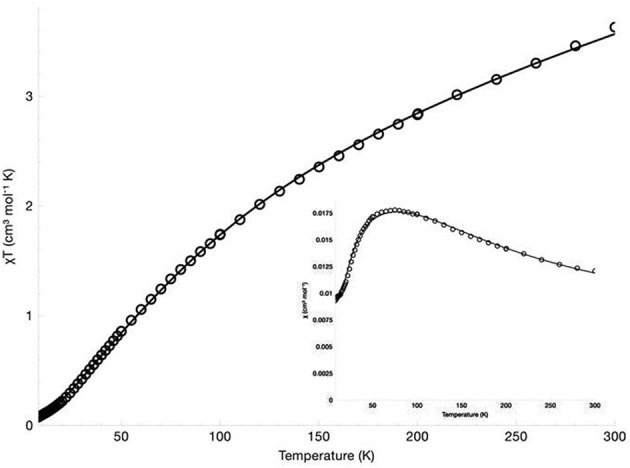
χM vs. T, and χMT vs. T (insert) plots for [Ni2(L1)(μ-OAc)(H2O)2](ClO4)2·H2O.